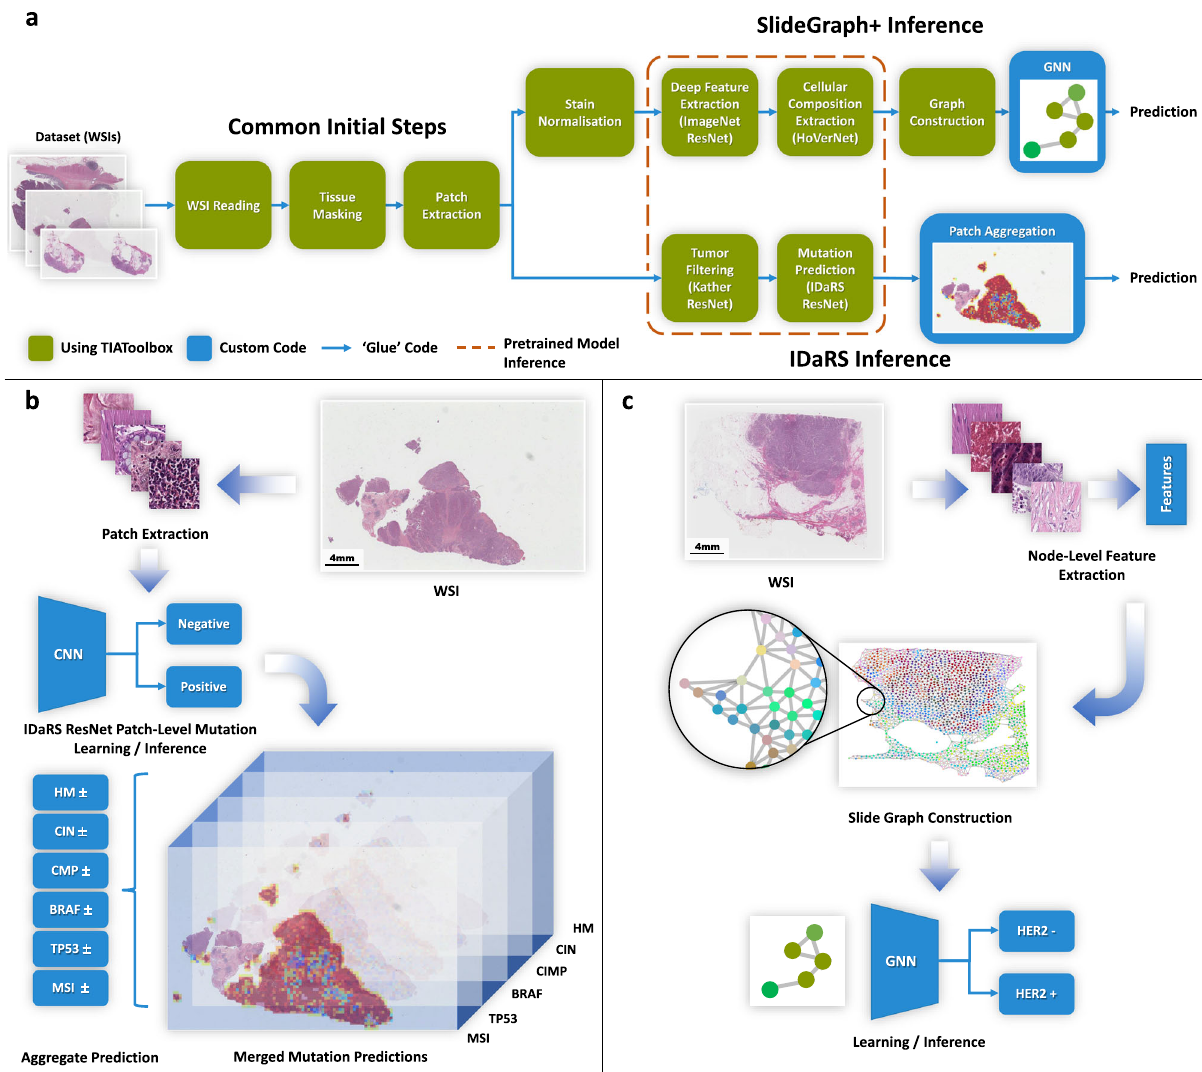
Fig. 4 Example usage of TIAToolbox modules in AI pipelines. The diagram shows the main steps of the SlideGraph and IDaRS pipelines and how modules in TIAToolbox have been used to replicate these pipelines. a Simpli fi ed block diagram of the main steps involved in each of the example pipelines. Several of the steps at the start of these pipelines are common between the two methods and are provided by TIAToolbox. Additionally, many of the steps where the pipelines diverge are also included in the toolbox. Custom code is only required for one or two steps in each pipeline in addition to gluing together each of the pipeline stages, or for some custom visualization. The same pretrained models can be used for inference in both IDaRS and SlideGraph + pipelines. b The main steps of the IDaRS pipeline for an example WSI. For each input patch a mutation prediction (positive or negative) is made and the results merged. Each component of the output vector is represented as a plane in a stack. c An example WSI and the resulting graph from the SlideGraph + pipeline. Nodes are colored in RGB space via a uniform manifold approximation and projection (UMAP) of the feature vectors assigned to the